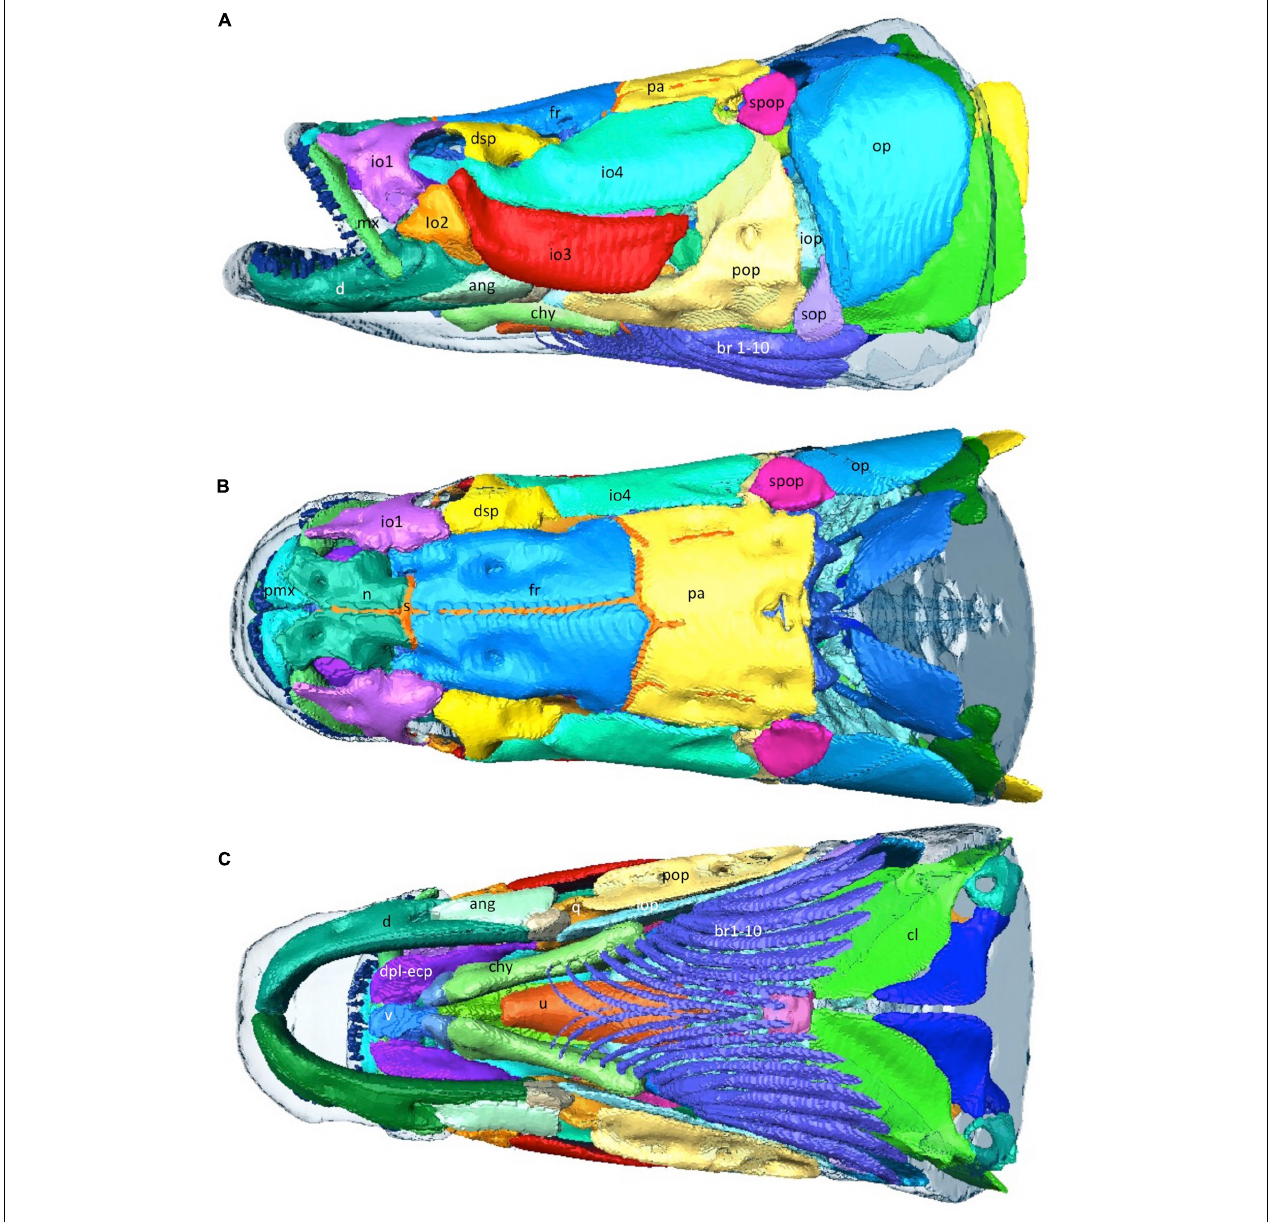
FIGURE 9 | Musculoskeletal -Head. (A–C) 3D reconstructions from CT data, of the external bony armor plates of the head with integument overlain as transparent surface. Abbtp, anterior basibranchial toothplate; ang, angular; ant, antorbital; br, branchiostegal rays; chy, Ceratohyal; cl; d, dentary; dsp, dermosphenotic; fr, frontal; io 1–4, infraorbital 1–4; iop, interopercular; iop, infraopercular; mx, maxilla; n, nasal; op, opercle; pa, parietal; pmx, premaxilla; pop, preopercle; q, quadrate; s, suture; sop, subopercle; spop, suprapreopercle; u, urohyal; v, vomer. (Bones referenced as per Steward